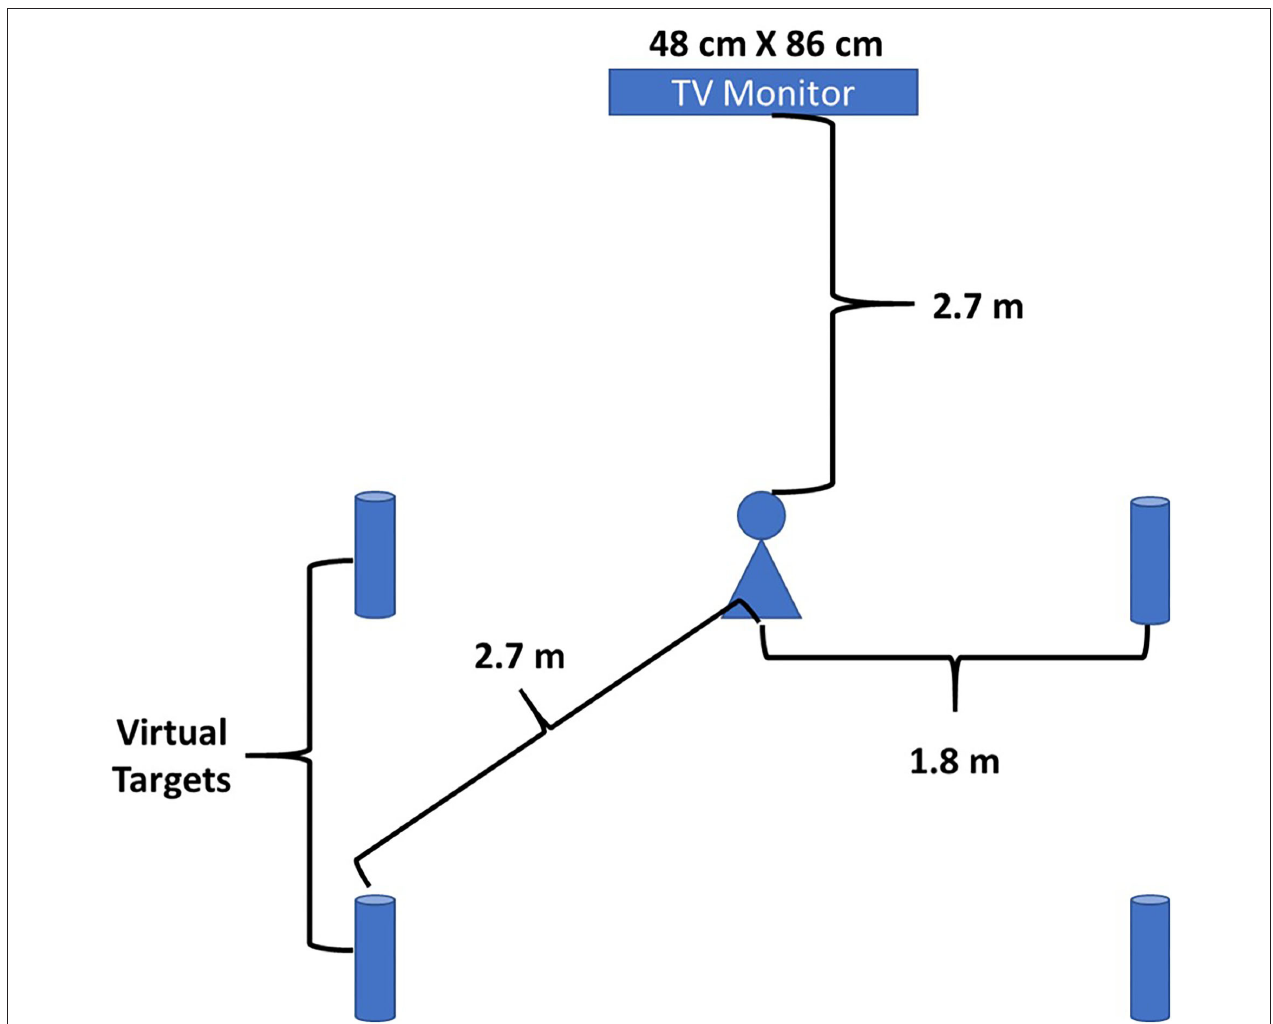
FIGURE 1 | Schematic of the set-up used for the WBRA